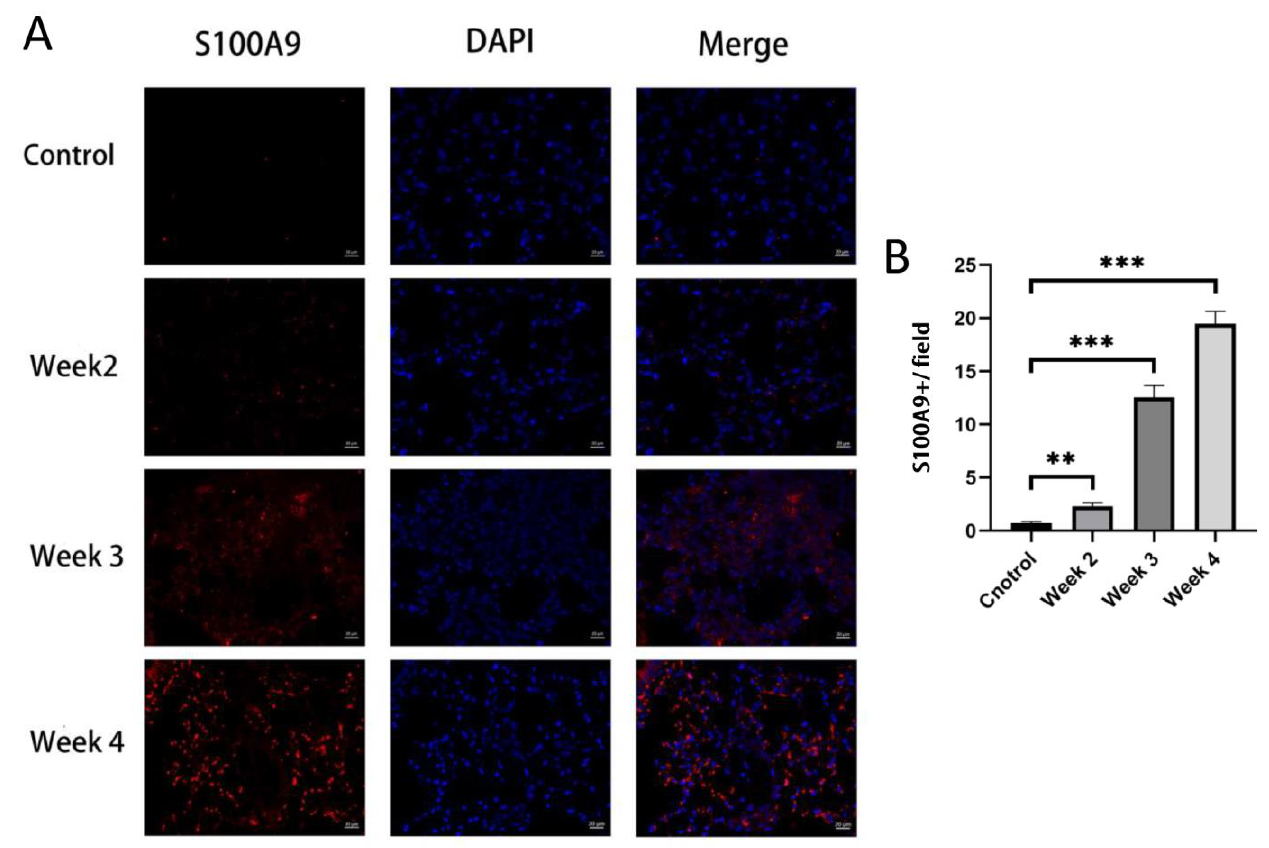
Figure 6. Immunofluorescence stained of S100A9 in lung tissues. The mice in the control group did not receive irradiation, while the mice in the irradiation group were detected at 2, 3 and 4 weeks after irradiation. ( A ) Immunofluorescence staining of S100A9 (red) and DAPI (blue) in lung tissues from normal and RILI mice (bars, 20 µ m). ( B ) Quantification of the positive signals in immunofluorescence images of S100A9. All graphs show the means ± SEM of at least three independent experiments. Statistical significance was analyzed by two-tailed t -test, ** p < 0.01, and *** p < 0.001 compared to control.